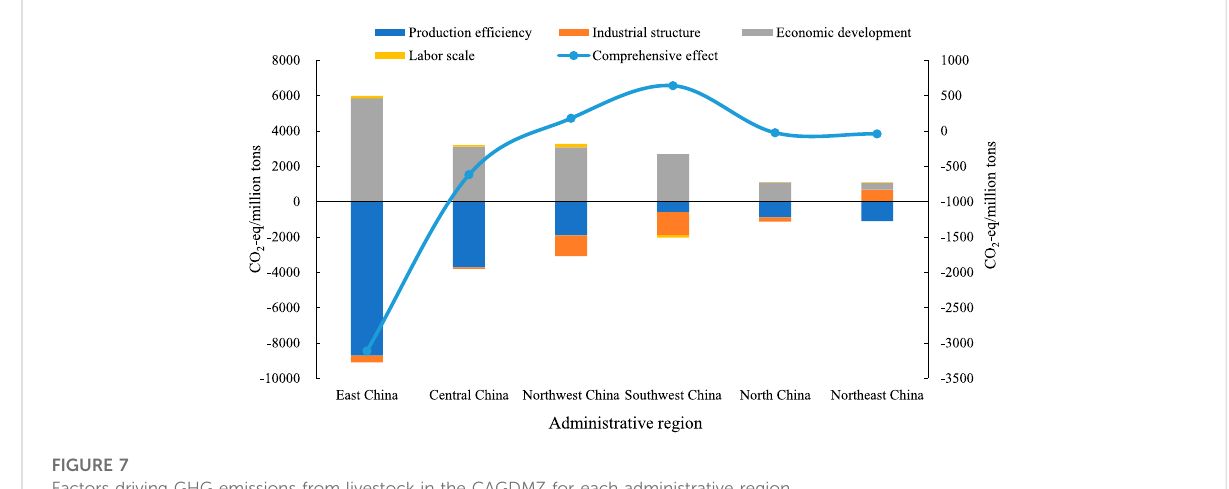
FIGURE 7 Factors driving GHG emissions from livestock in the CAGDMZ for each administrative